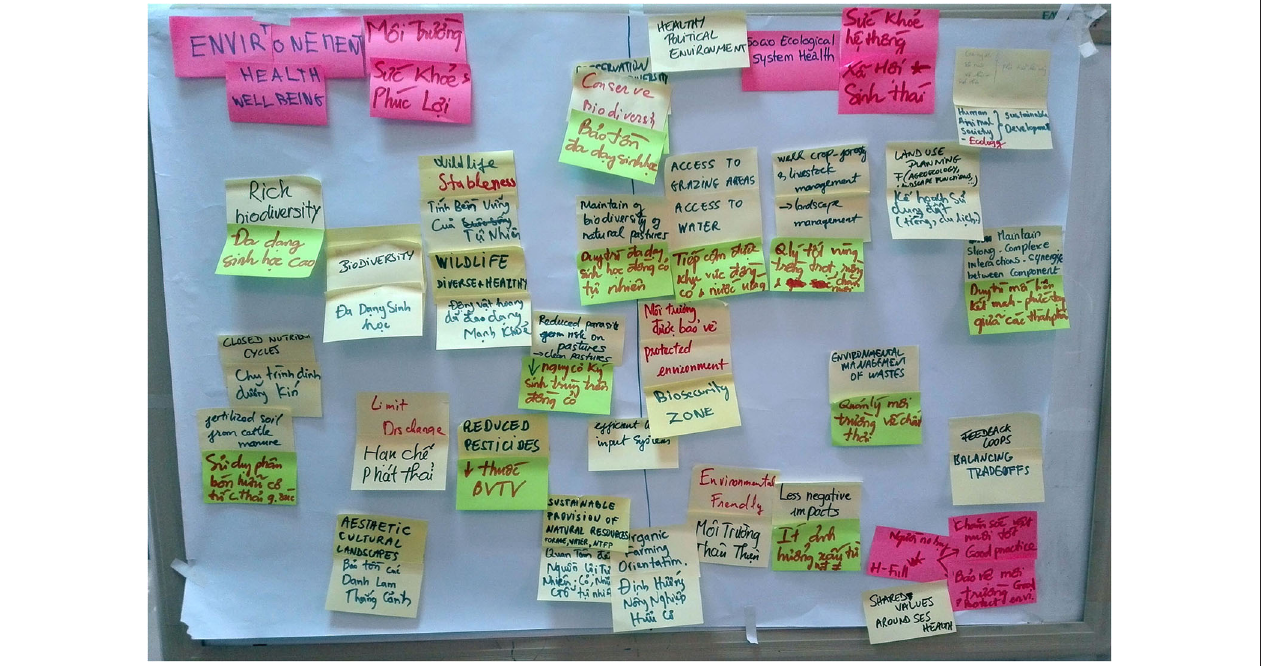
FIGURE 3 | Key words and concepts suggested by participants for the collective definition of a context-based SESH of livestock-based systems (Hanoi, Vietnam, December 2019). The picture shows two the four boards produced (Environment Health, Socio-Ecological System Health) to co-design the components of the system (see Figure 2 , steps 1–3). All key words and concepts were written in English and Vietnamese, and all discussions were expressed in any of these two languages and simultaneously translated.